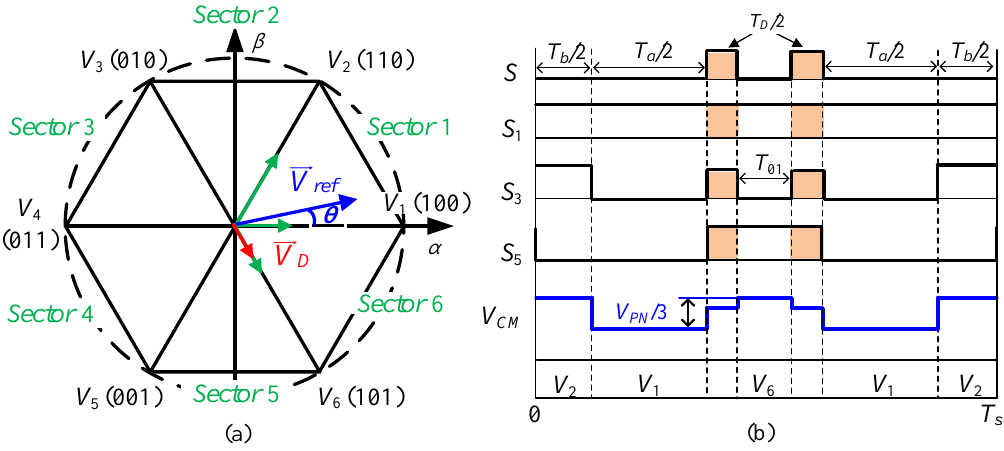
Figure 7. Space vector diagram of the proposed CMR-SVM method with shoot-through states insertion. ( a ) SVM diagram and ( b ) switching states in Sector 1.